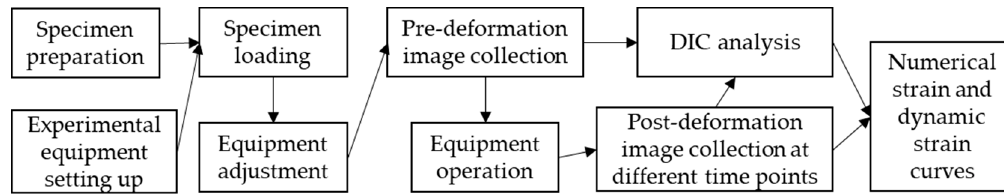
Figure 2. Implementation of digital image correlation (DIC) for strain measurement.